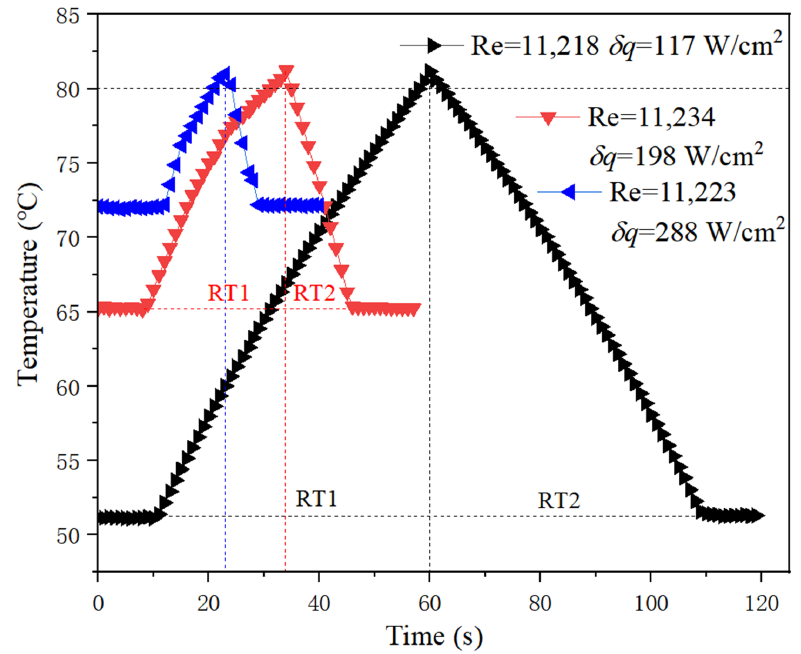
Figure 12. Temperature response characteristics at high flow rate.